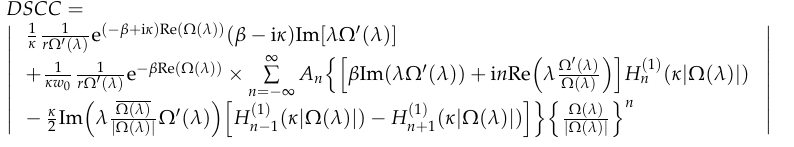
Figure 3. Polar graph of DSCC around the elliptical opening with ka = 0.1 and m = 1/4.